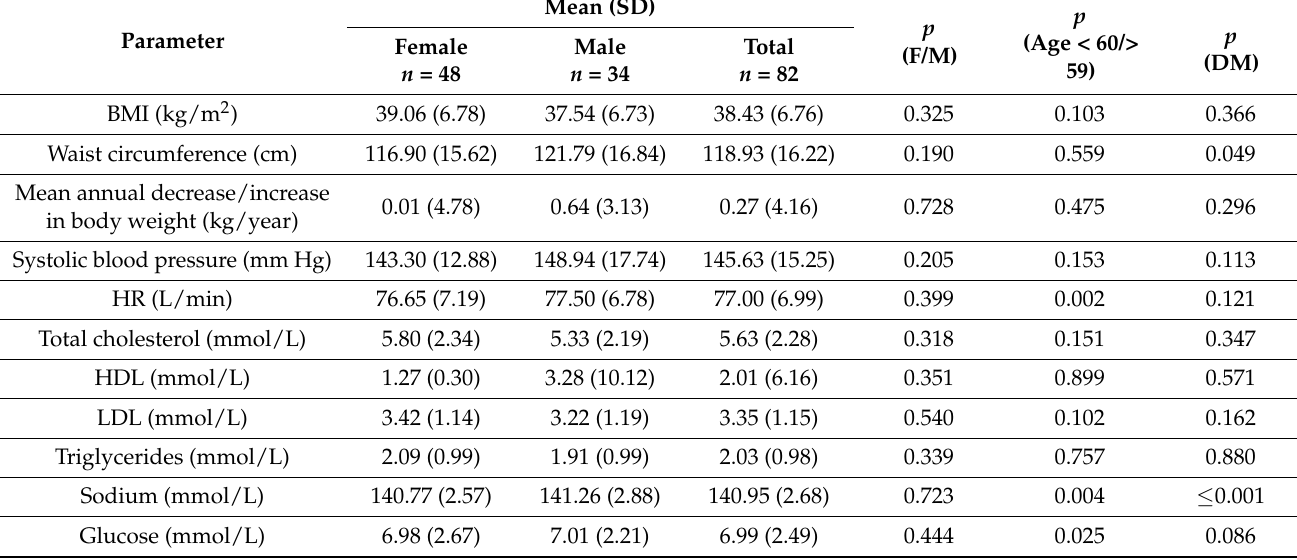
Table 1. Descriptive statistics of BMI, waist circumference, mean annual decrease/increase in body weight, blood pressure and HR values, and the results of laboratory blood tests and their differentiation by gender, age, and the presence of DM (with a Mann–Whitney U